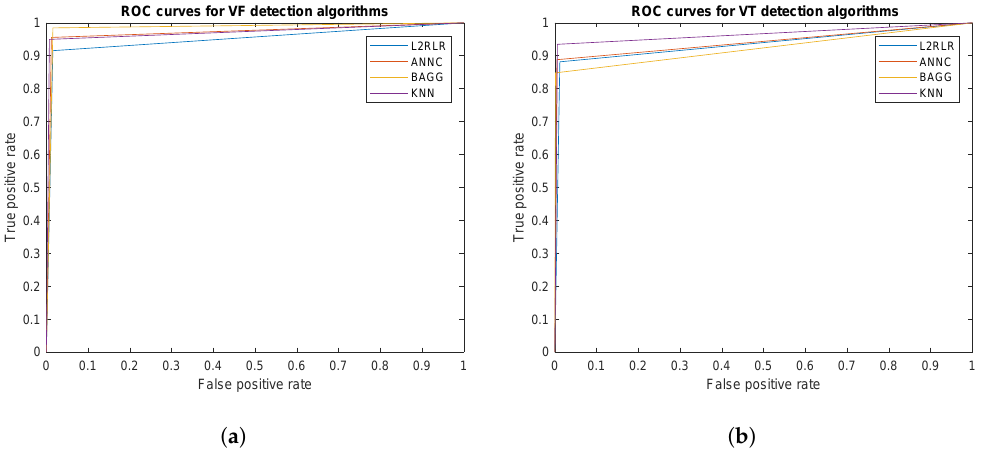
Figure 6. ROC curve for VF ( a ) and VT ( b ) in L2 Regularization ( L 2 RLR ), adaptive neural network ( ANNC ), Bagging ( BAGG ), and K-nearest neighbor ( KNN ) individual